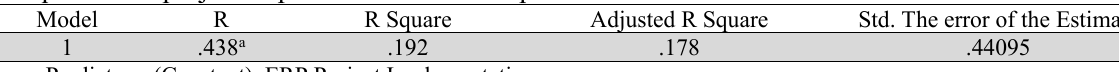
R-Square ERP project implementation of firm performance